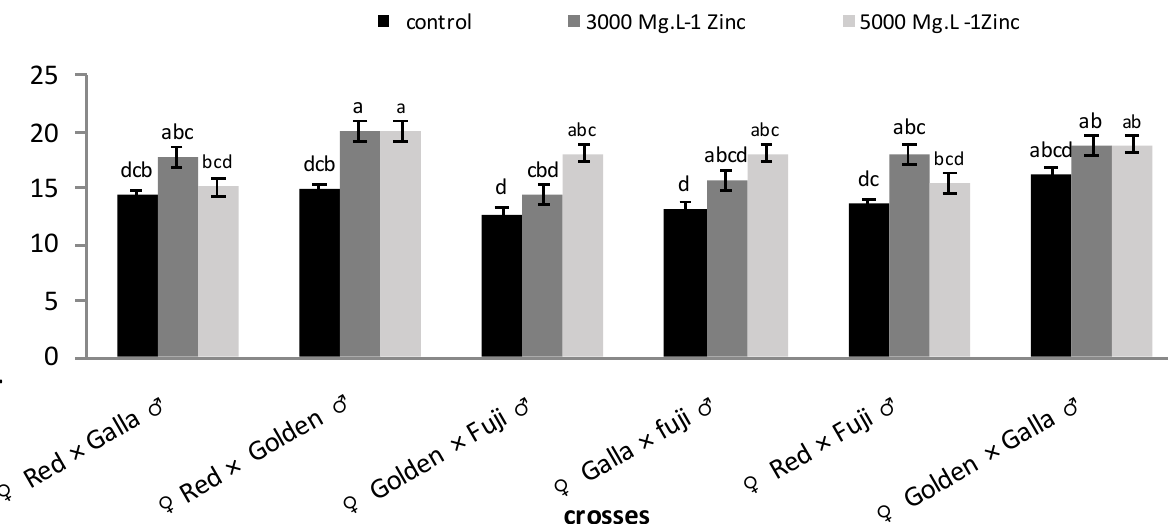
Fig 3. The interactions between Zn concentration and crosses on the pollen tube penetration into the beginning of the style in different crosses. Means in each column, followed by similar letter (s) are not significantly different at 1% probability